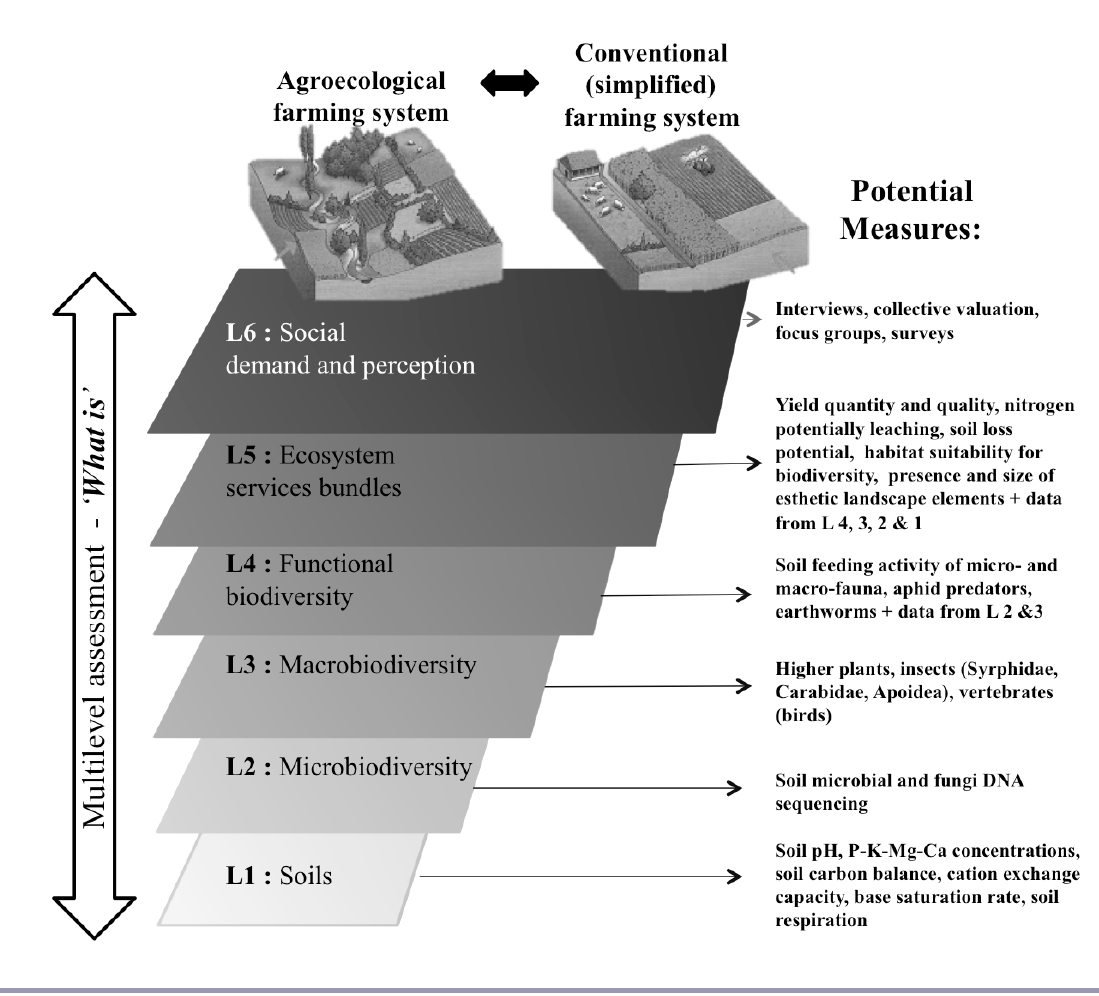
Fig. 2. A multilevel (L) methodology to allow a better understanding of agroecological practices and their impacts on ES flows and underlying processes. Measurements can be done in agroecological parcels and conventional ones in order to have a reference point. Examples of indicators are provided on the